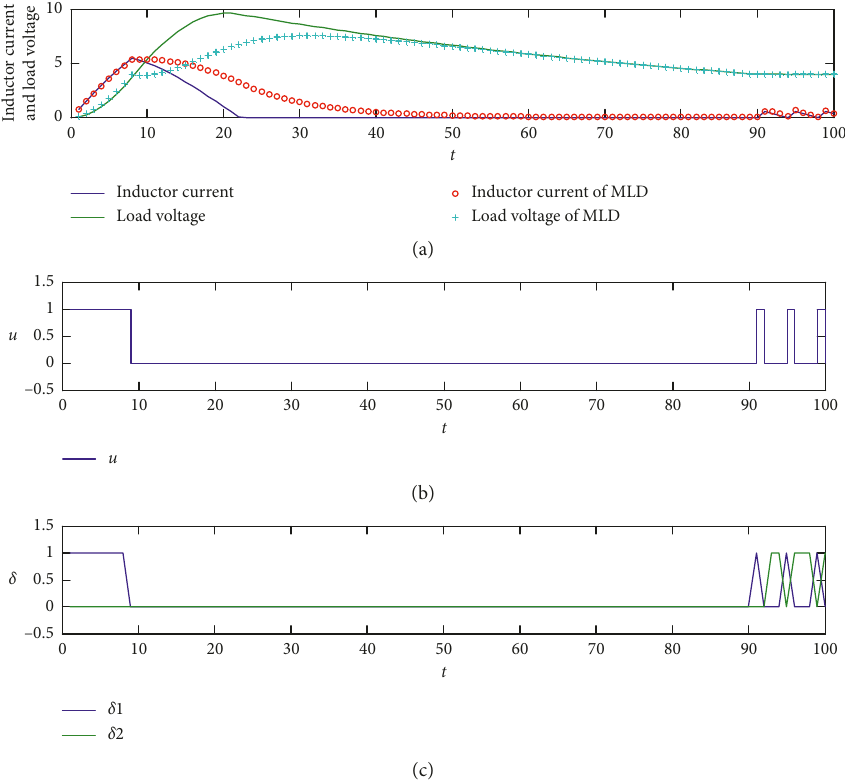
Figure 5: MSMLD control curve without state conversion. (a) System state and model state. (b) Control input. (c) Auxiliary logic